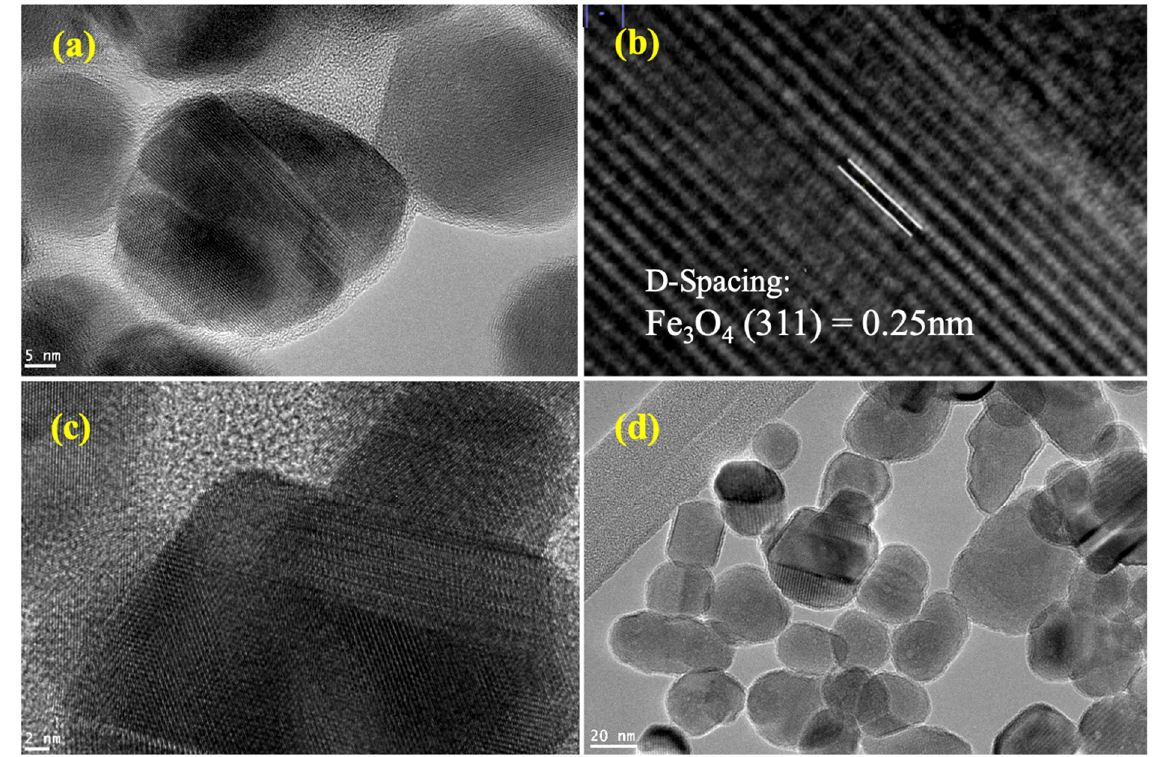
Figure 2. HR-TEM for ( a ) Fe 3 O 4 /RGO/PEG at the scale of 5 nm, ( b ) d-spacing of 0.25 nm for Fe 3 O 4 nanoparticles, ( c ) Fe 3 O 4 /RGO/PEG at the scale of 2 nm showing clear cubic structure and ( d ) nanoparticles of the Fe 3 O 4 /RGO/PEG nanocomposite at the scale of 20 nm.